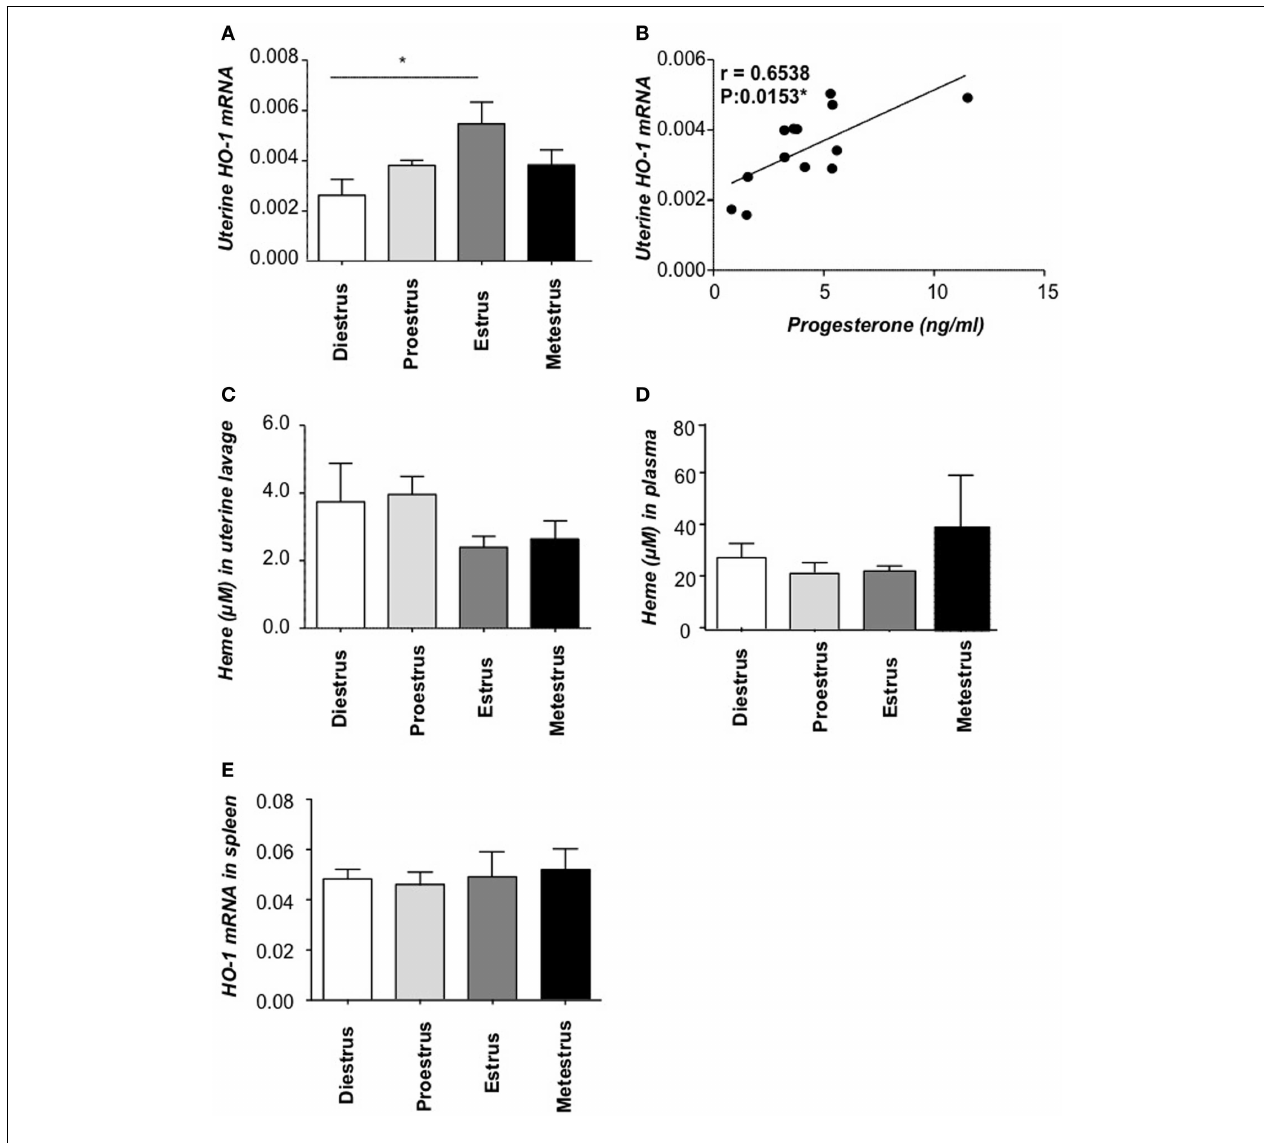
heme in uterine lavage and (D) heme levels in plasma. (E) HO-1 mRNA levels in spleen of Hmox1 + / + female mice. * p < 0.05, n = 4 mice/phase were included and the statistic analysis was performed by two-way